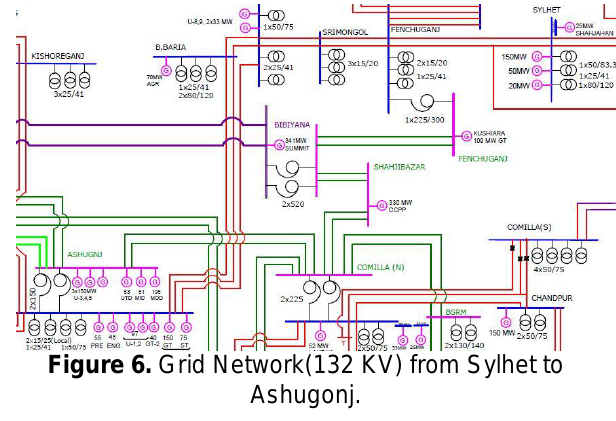
Figure 6. Grid Network(132 KV) from Sylhet to